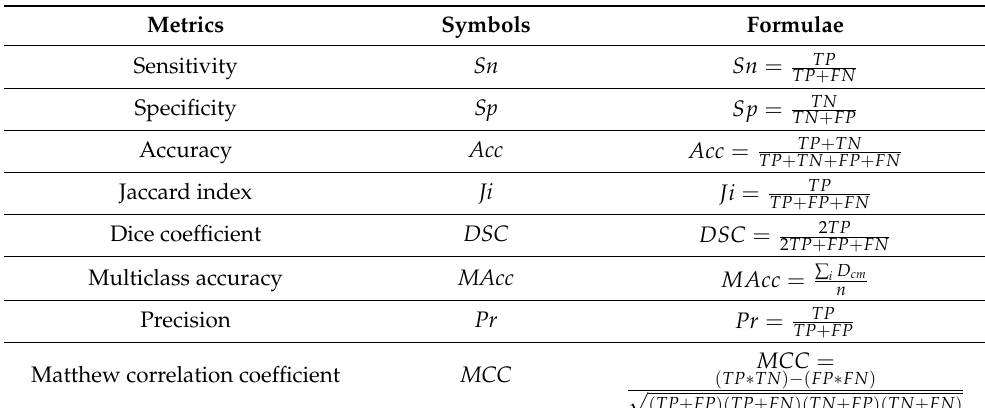
Table 3. Performance Evaluation